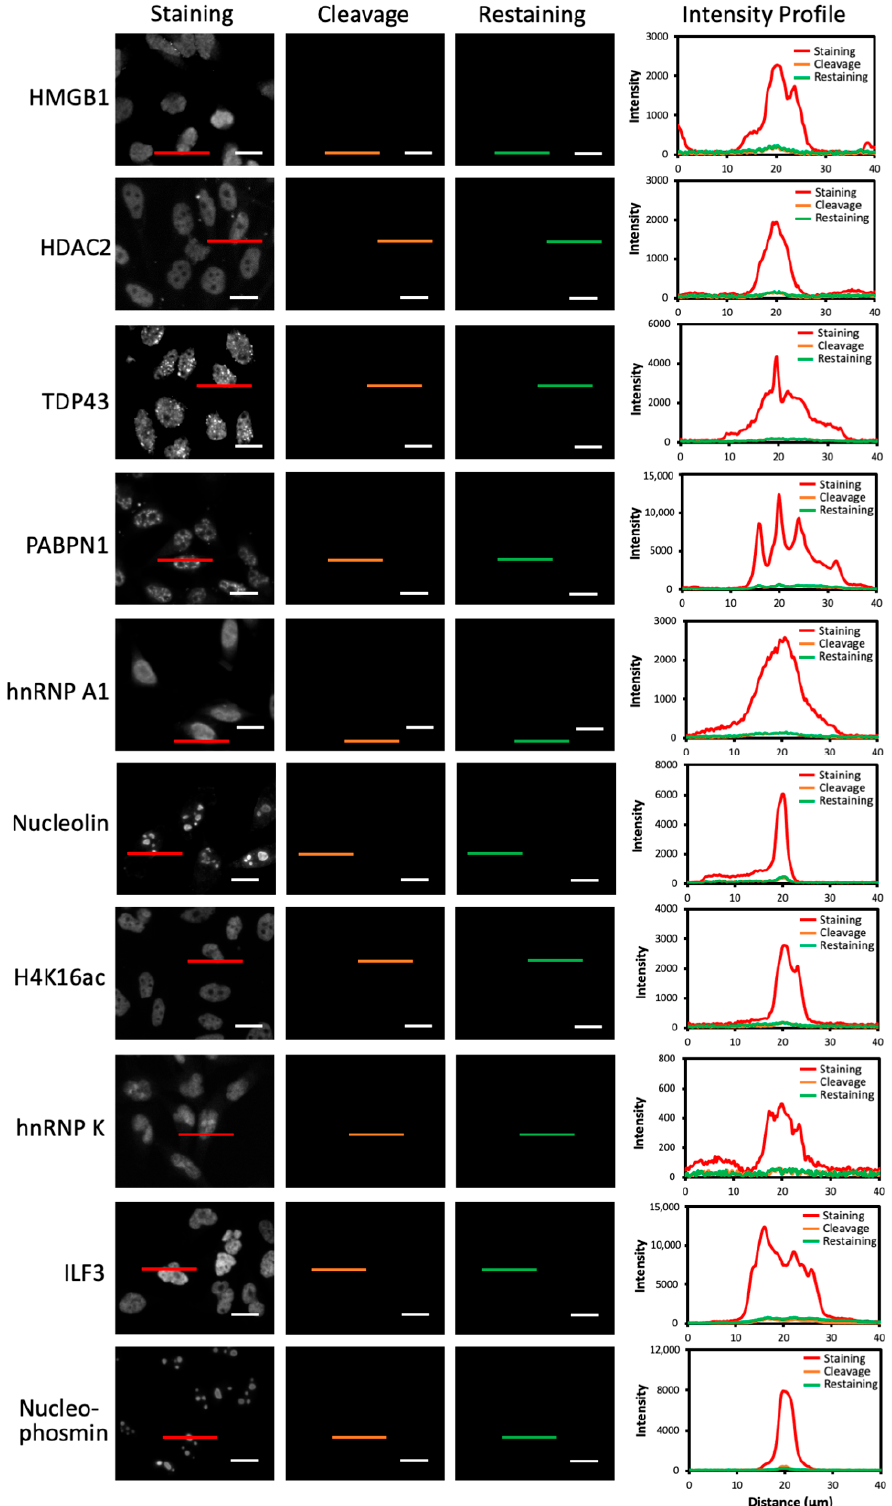
Figure 4. Ten proteins in HeLa cells were stained with tyramide-N 3 -Cy5 (the first column). Subsequently, the staining signals were removed by PTA and TCEP (the second column). Then, the cells were reincubated with tyramide-N 3 -Cy5 (the third column). The fourth column shows the signal intensity profiles corresponding to the red, orange and green line positions in the first three columns. Scale bars, 15 μ m.